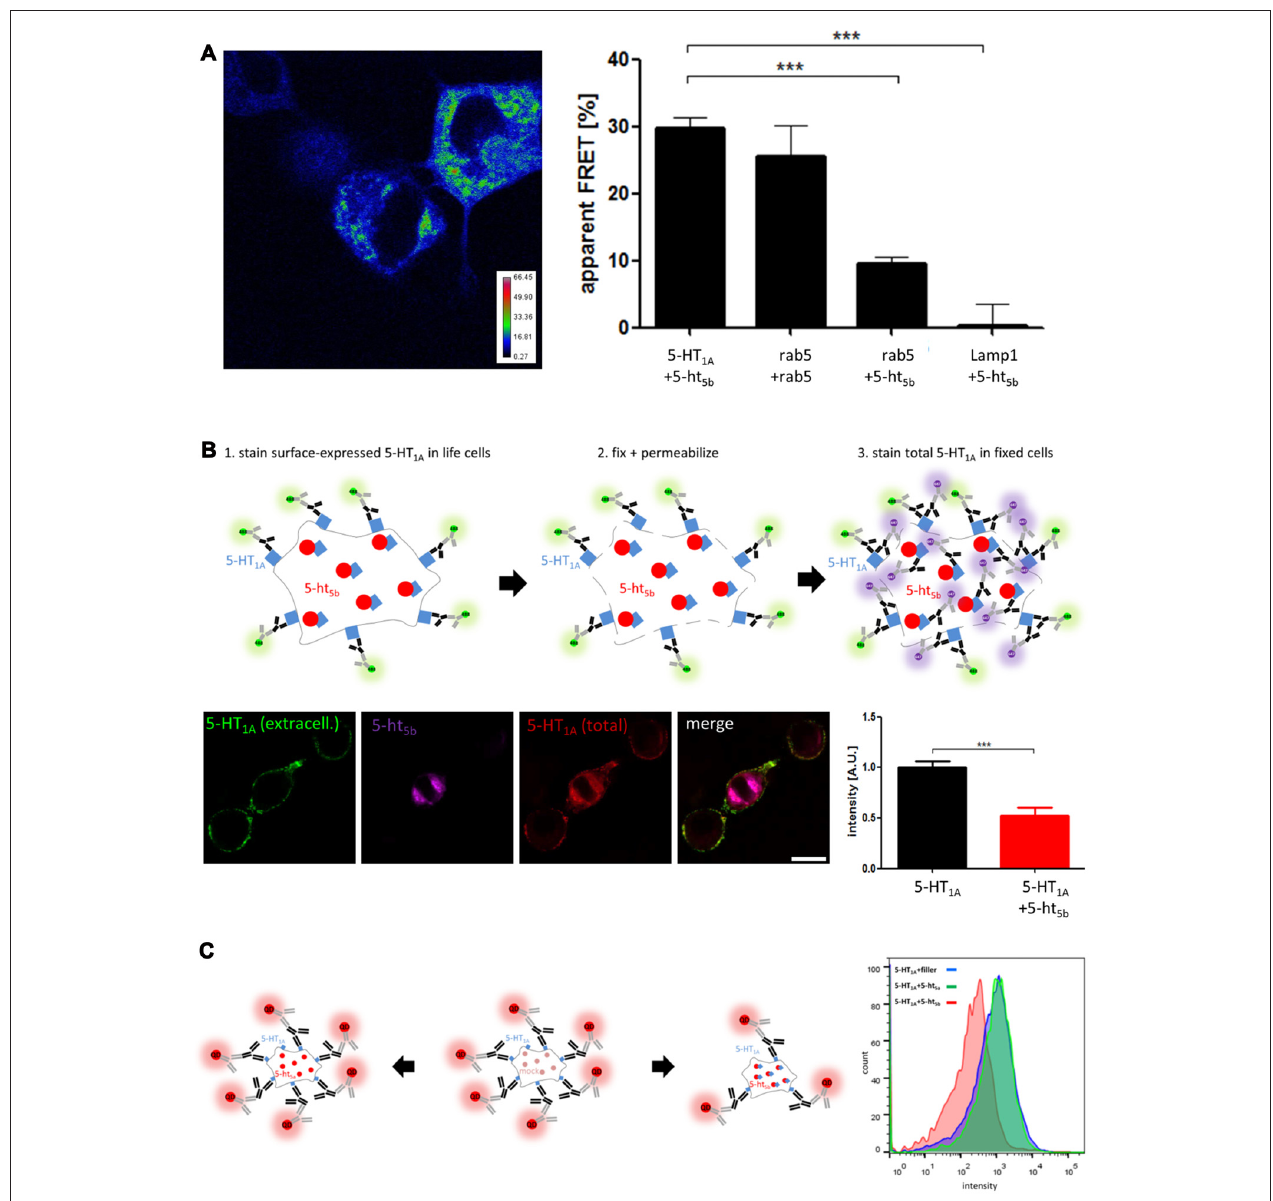
FIGURE 4 | Analysis of receptor interaction. (A) Acceptor-photobleaching Förster Resonance Energy Transfer (abFRET) microscopy was used to determine the extent of protein:protein-interaction. Protein pairs of 5-HT 1A :5-ht 5b , rab5:rab5, 5-ht 5b :rab5 and 5-ht 5b :Lamp1 were co-expressed in N1E-115 cells at equimolar concentrations and the apparent FRET efficiency (F app ) was measured. The color-coded image shows an exemplary experiment of 5-HT 1A :5-ht 5b , while the bar diagram shows the apparent FRET efficiencies of 5-HT 1A :5-ht 5b (29.74 ± 1.6), rab5:rab5 (25.58 ± 4.6), 5-ht 5b :rab5 (9.56 ± 1.1) and 5-ht 5b :Lamp1 (0.02 ± 0.7). Asterisks indicate significance ( ∗∗∗ p ≤ 0.001; one-way-ANOVA with Bonferroni’s post-test for multiple comparisons). (B) Immunohistochemical analysis of distribution and equal expression levels. Non-permeabilized cells were stained for 5-HT 1A (green), then fixed and permeabilized and stained again for 5-HT 1A (purple). 5-ht 5b is co-expressed in some cells as a fusion protein with a fluorescent tag (red). The fluorescence intensity of the first 5-HT 1A staining was then measured in cells expressing 5-HT 1A and in cells expressing 5-HT 1A and 5-ht 5b . The cartoon shows the experimental procedure. The bar diagram shows the mean fluorescence intensities of 5-HT 1A reactivity in cells expressing only 5-HT 1A and in cells expressing 5-HT 1A (1.0 ± 0.06) and 5-ht 5b (0.52 ± 0.08) ( ∗∗∗ p ≤ 0.001; unpaired t -test). (C) The effect of 5-HT 1A :5-ht 5b co-expression on 5-HT 1A surface localization was quantified by fluorescence activated cell sorting (FACS) analysis of N1E-115 cells expressing HA-5-HT 1A alone or together with 5-ht 5b . Expressing 5-HT 1A together with an equal amount of filler DNA was used to determine 5-HT 1A surface expression under control conditions (blue). Co-expression of 5-HT 1A with an equal amount of non-interacting 5-ht 5a did not change the degree of surface expression (green). Co-expression of 5-HT 1A with an equal amount of 5-ht 5b decreased the cell surface expression of 5-HT 1A by 48.8% ± 17.4%. The cartoon shows the experimental procedure. Labeling was directed at HA-tag on 5-HT 1A with quantum dot-coupled secondary antibodies. To avoid skewing results by transcription